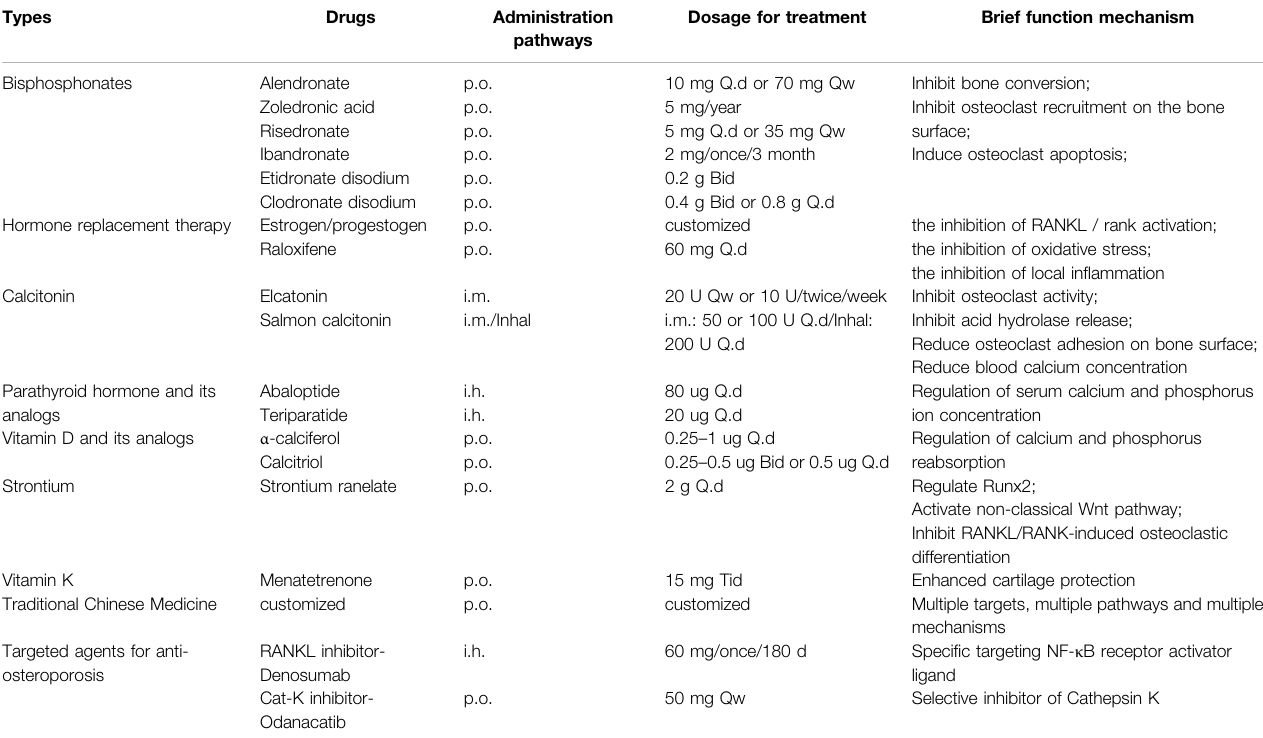
TABLE 1 | Some anti-osteoporpsis durgs currently in use.